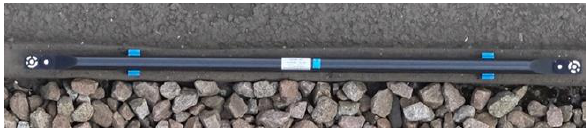
Fig. 9: Highly accurately calibrated CFRP scale for checking the local image